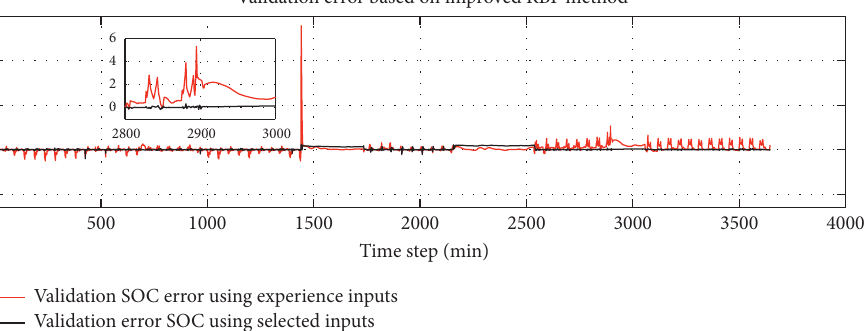
Figure 3: Validation results for different model inputs using proposed RBF.